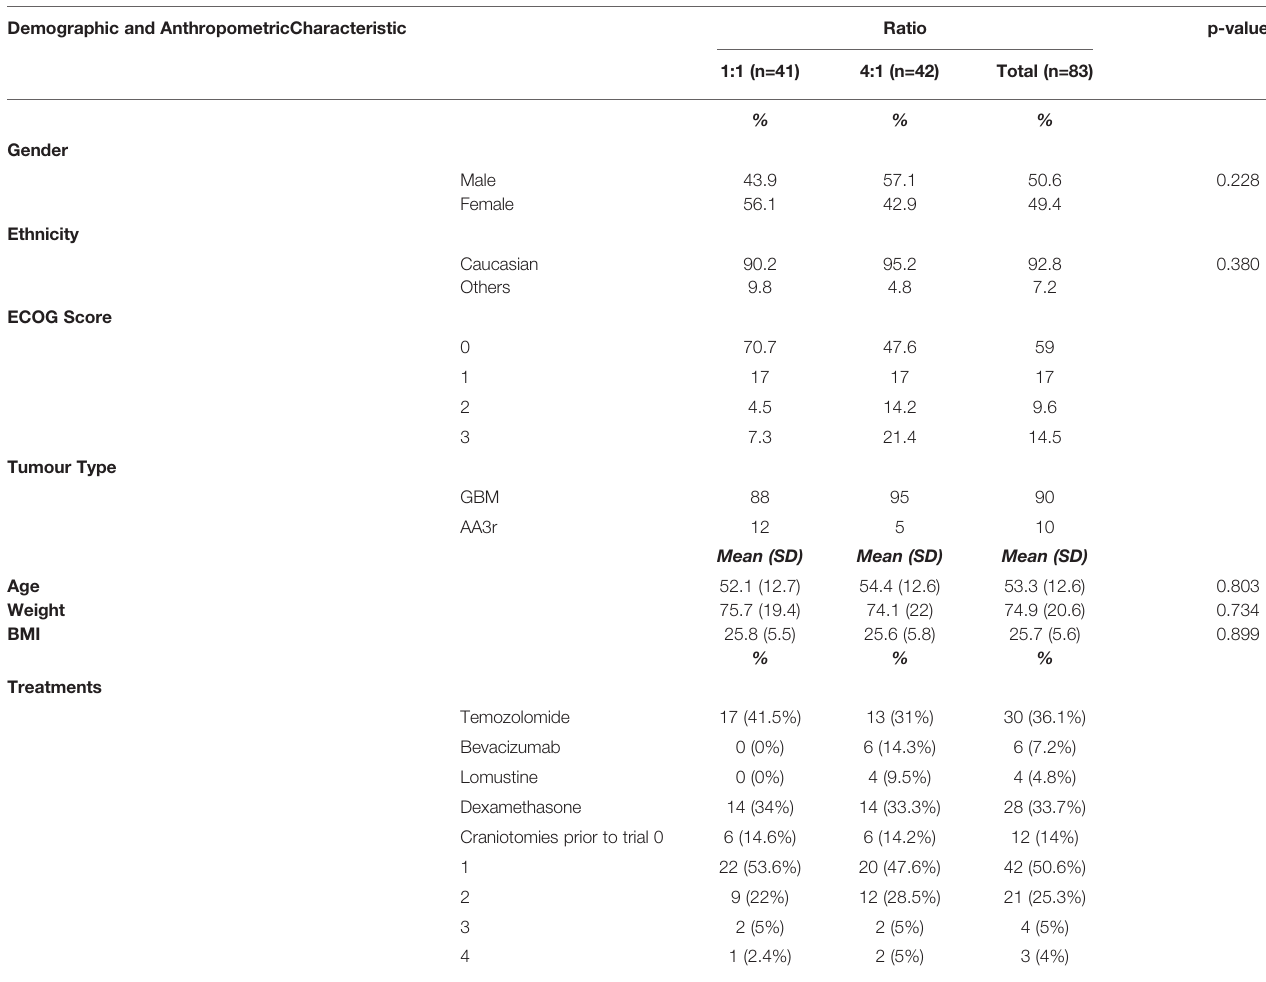
TABLE 1 | Basic demographics of study participants. Demographic and AnthropometricCharacteristic